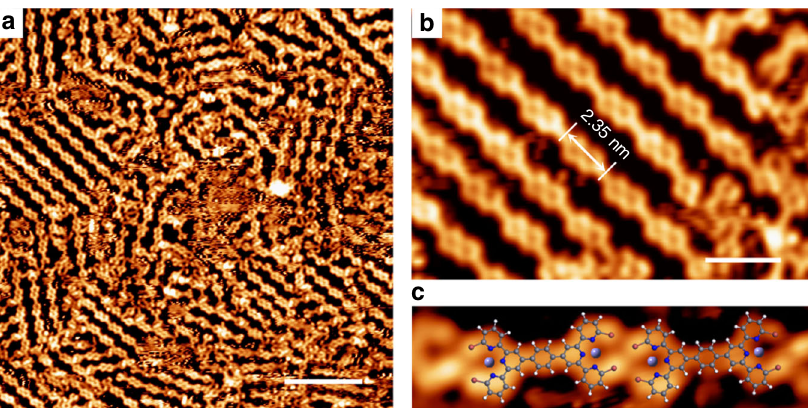
Fig. 4 Molecular conformers and assembled structures in the presence of Fe. a STM overview of the chain structures observed when the sample held at 100 K. b Close-up inspection of the chains. Most molecules are cis-D 2h conformers. c Tentative structural model. Fe coordination centers are represented by purple spheres. Scale bars: ( a ) 10 nm; ( b ) 3 nm. Data acquisition conditions ( T = 100 K): ( a , b and c ) − 1.8 V,